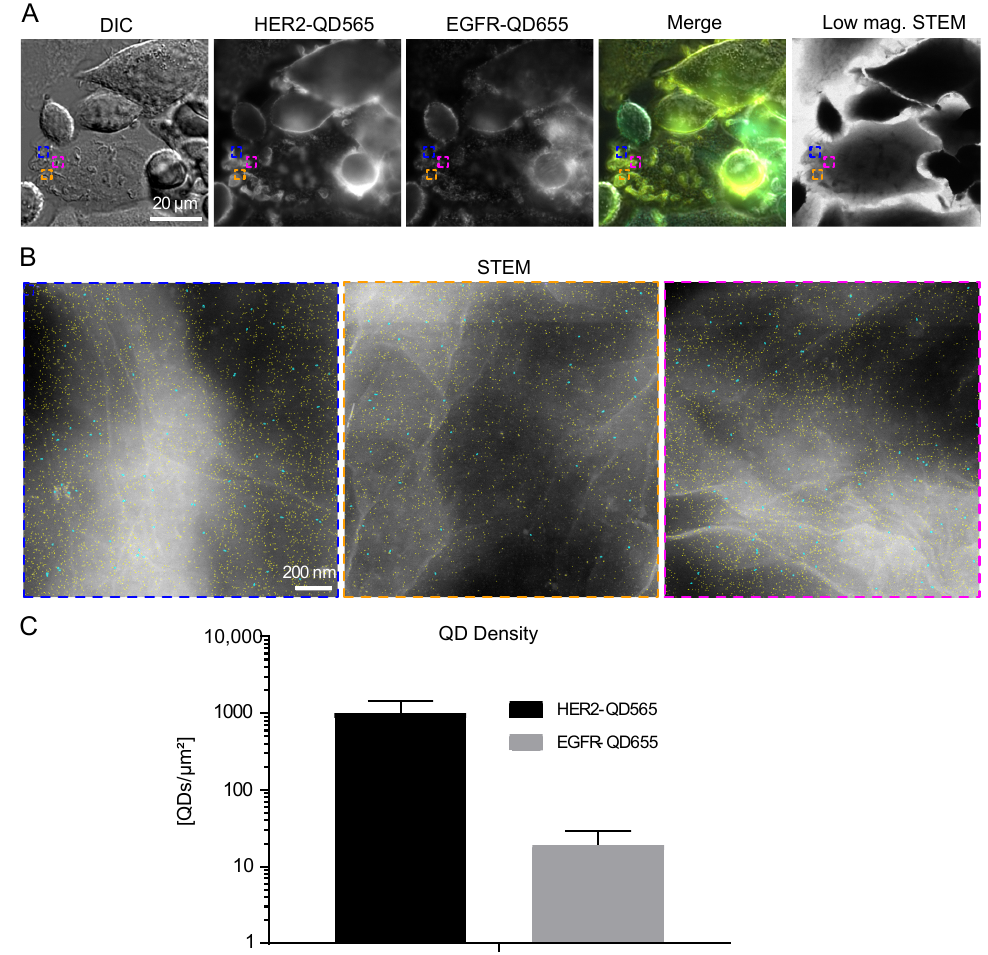
Figure 3. HER2 and EGFR expression on large membrane protrusions. ( A ) Correlative fluorescence and low magnification STEM of SKBR3 cells labeled for HER2-QD565 and EGFR-QD655. Light microscope images were acquired using a 63× oil objective. The same region is shown in the STEM image at M = 800×. Colored rectangles depicted in ( A ) indicate the magnified areas shown in ( B ) acquired with dark field STEM at M = 120,000×. Individual quantum dots (QDs) are visible and outlined in cyan (EGFR labeled with streptQD655) and yellow (HER2 labeled with streptQD565). ( C ) Mean QD densities for HER2 and EGFR for all analyzed large membrane protrusion regions with standard deviation indicated. Colors in the merged images: yellow for HER2 and cyan for EGFR. Scale bars: 20 µm ( A ) and 200 nm ( B ).